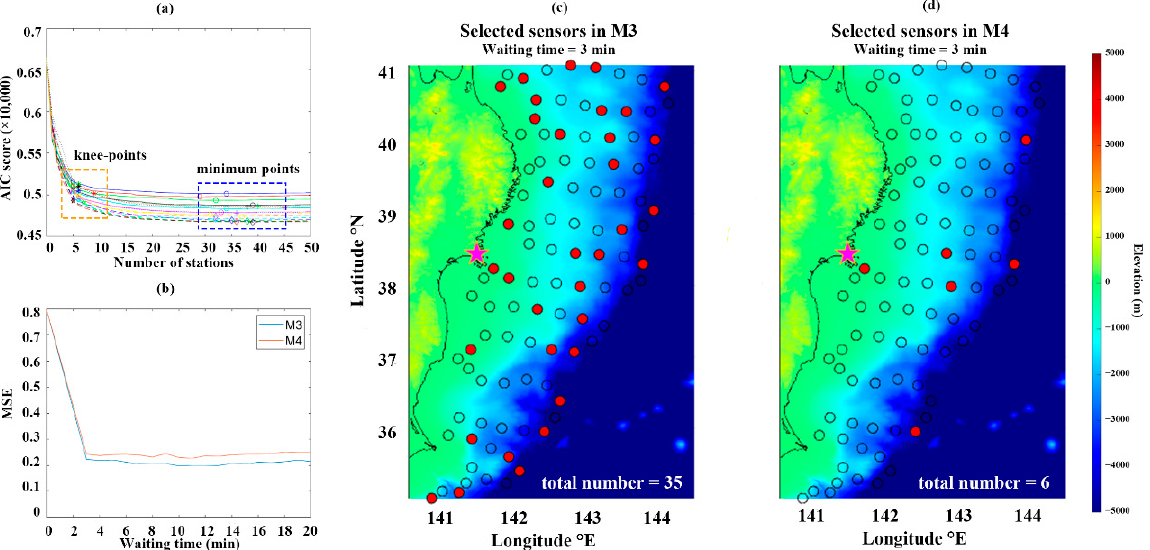
Figure 11. Results of the hazard-based early warning model for Onagawa: ( a ) AIC score plot, ( b ) MSE-waiting time plot, ( c ) optimal sensor map for M3, and ( d ) optimal sensor map for M4. The pink star represents the target location (Onagawa). The red and empty circles represent the selected and unselected sensors, respectively.